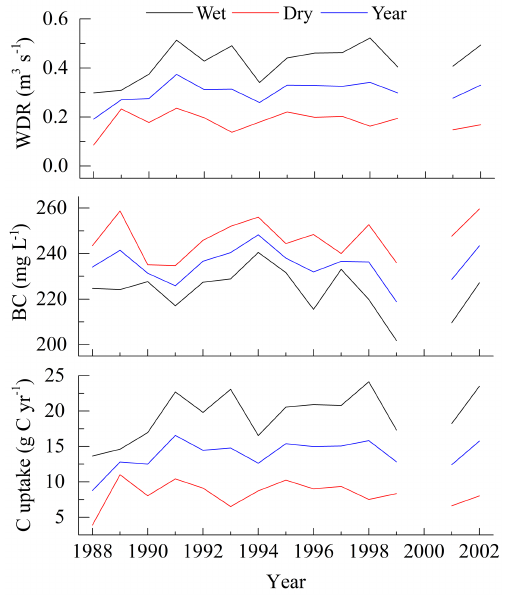
Figure 2. Variation in run-off, ion concentration, and carbon sink for the LHT station (1988–2002).